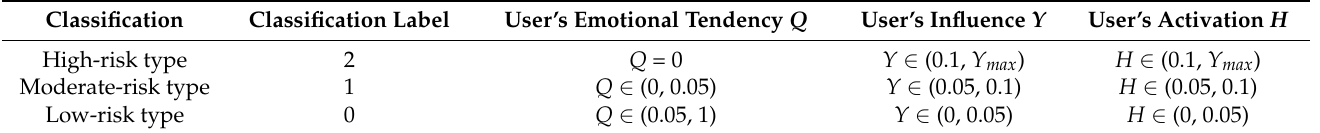
Table 3. Criteria for classification of user